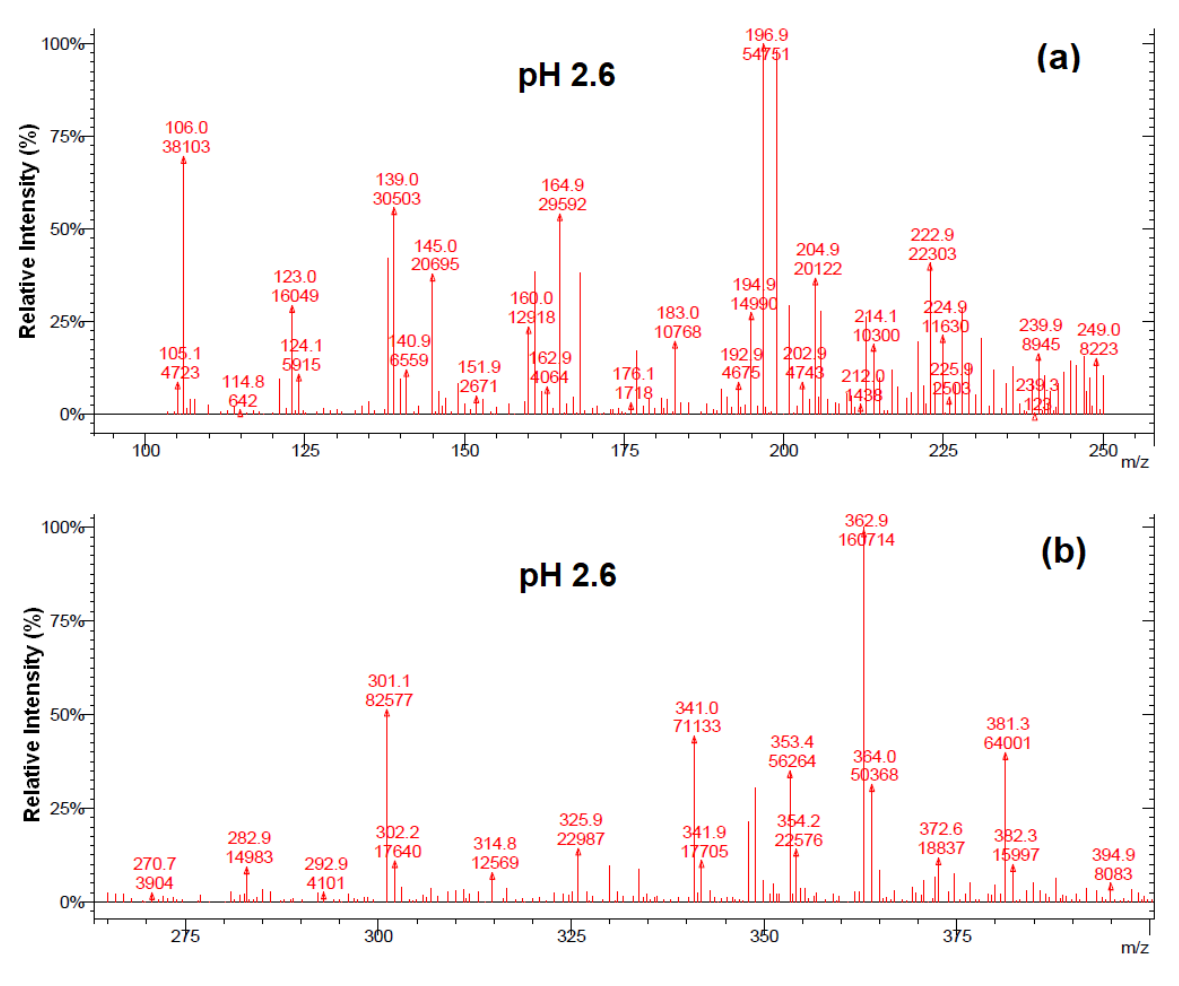
Fig. S7. Positive-ion ESI–MS spectrum for the complexes formed in the VOSO system at ligand-to-metal molar ratio 2:1, pH 2.6, C